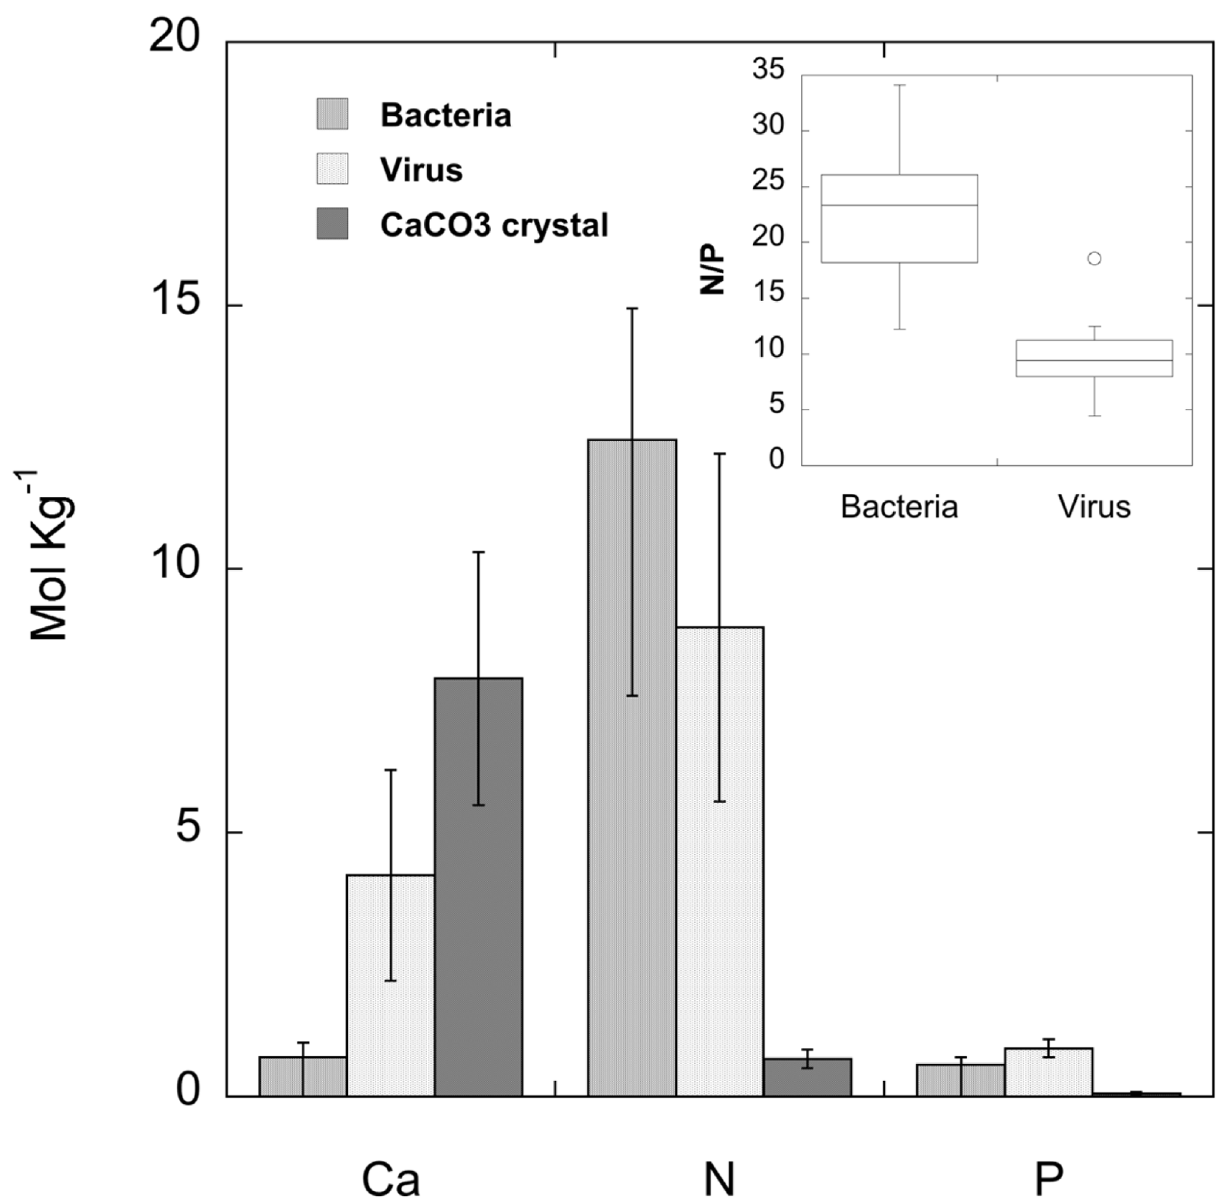
Fig 6. Calcium, nitrogen and phosphorus content obtained by X-ray analysis of single bacterial cells and viruses incorporated in the biogenic calcium carbonate crystal, and of the crystal itself. N = 13. Inlet: Box and whisker plot of N/P ratio in bacteria and